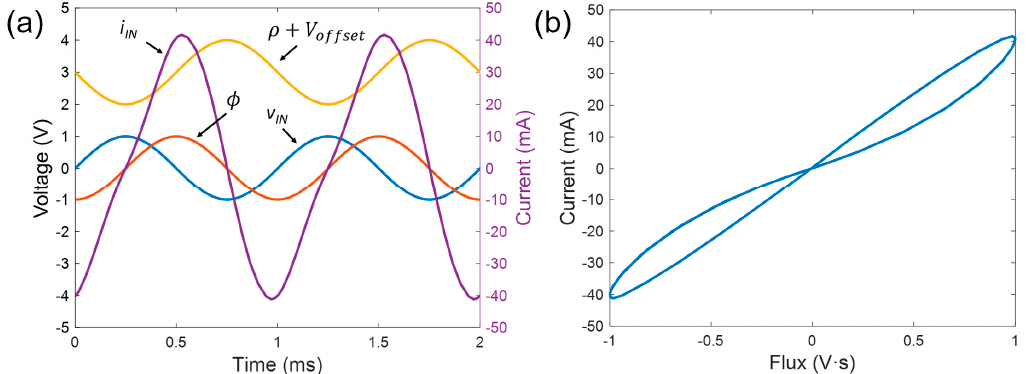
Figure 9. TIF-controlled resistor implemented by means of a photoresistive opto-isolator. The schematic of both summing amplifier and double integrator circuit is not shown for simplicity.